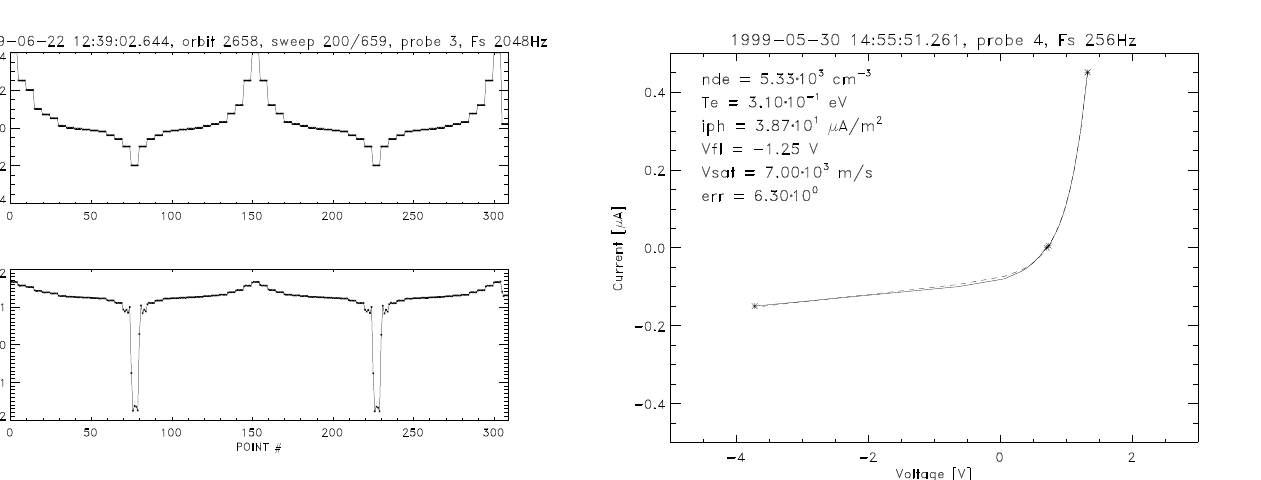
Fig. 3. An example of current sweep on an EMMA probe with a theoretical curve fitted to it. Solid curve - measured data, dashed curve - theoretical dependence (see